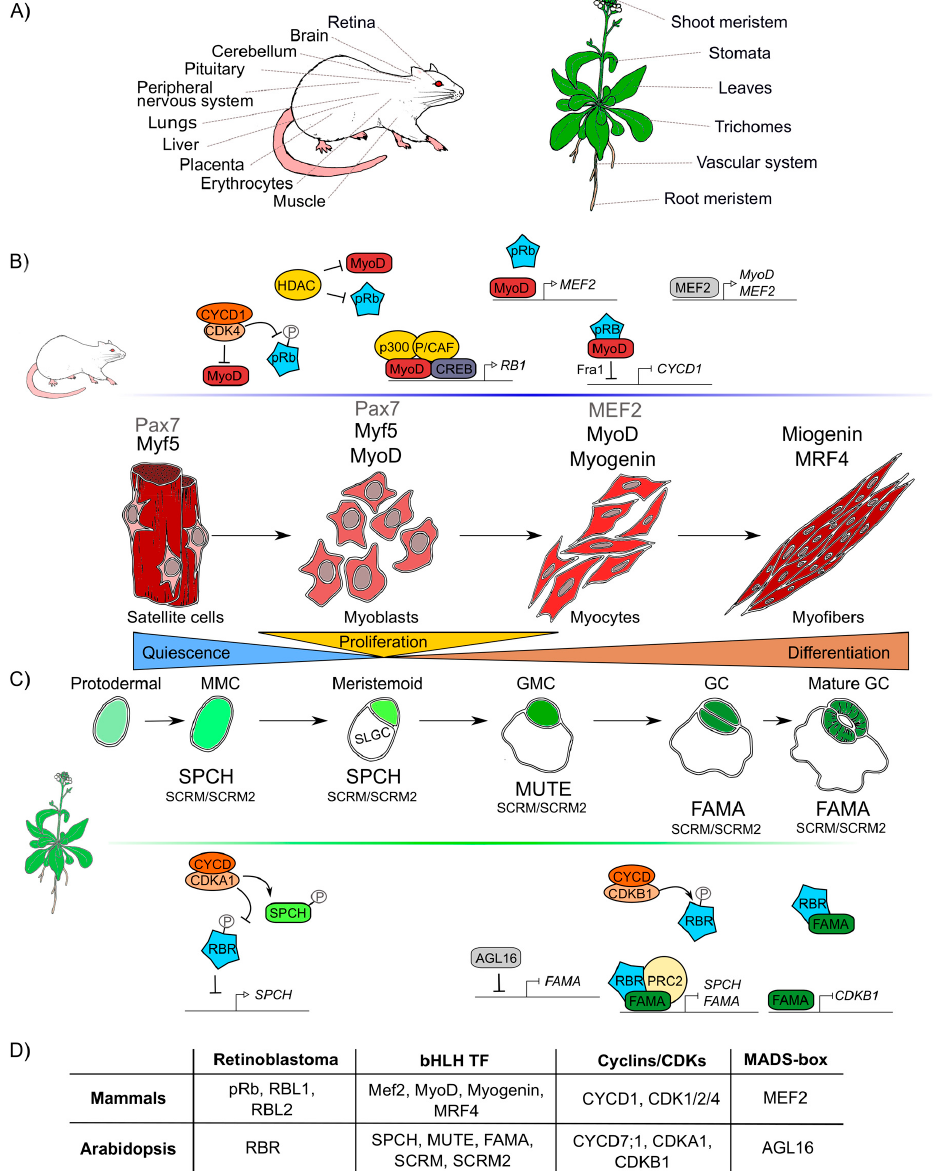
Figure 3. Retinoblastoma proteins are involved in cell di ff erentiation in mammals and plants. ( A ) Mammals’ and plants’ organs whose di ff erentiation depends on pRb / RBR. ( B ) Sequential steps of skeletal muscle di ff erentiation in mammals. Shown are pRb interactions and bHLHs-family proteins (Mef2, MyoD, Myogenin, MRF4), involved in muscle quiescence maintenance, proliferation, and di ff erentiation. ( C ) Sequential steps of guard cells di ff erentiation in Arabidopsis. Shown are RBR interactions and bHLHs-family proteins (SPCH, MUTE, FAMA, SCRM, SCRM2) involved in quiescence maintenance, proliferation, and di ff erentiation of guard cells. ( D ) Correlations between components involved in muscle and guard cell development in mammals and Arabidopsis, respectively. Di ff erentiation in both lineages involves proteins of the pRb, bHLH TF, cyclins and CDKs, MADS-box TF